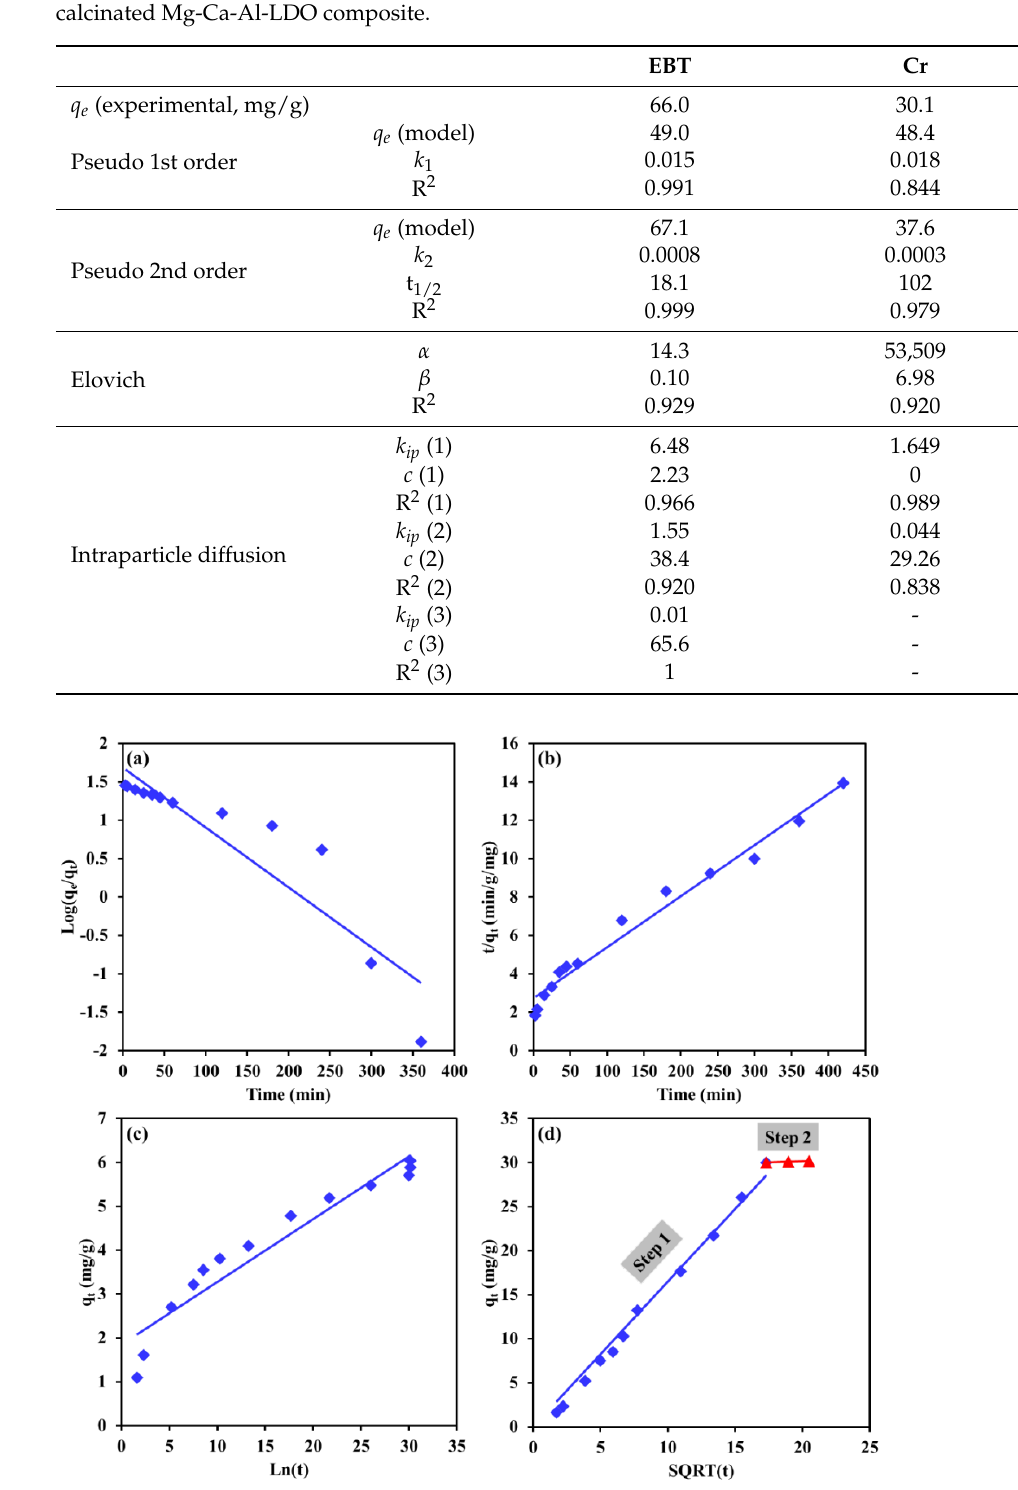
Figure 12. Linearized kinetic models fit of Cr removal by Mg-Ca-Al-LDO composite for ( a ) pseudo 1st order, ( b ) pseudo 2nd order, ( c ) Elovich and ( d ) intraparticle diffusion models.